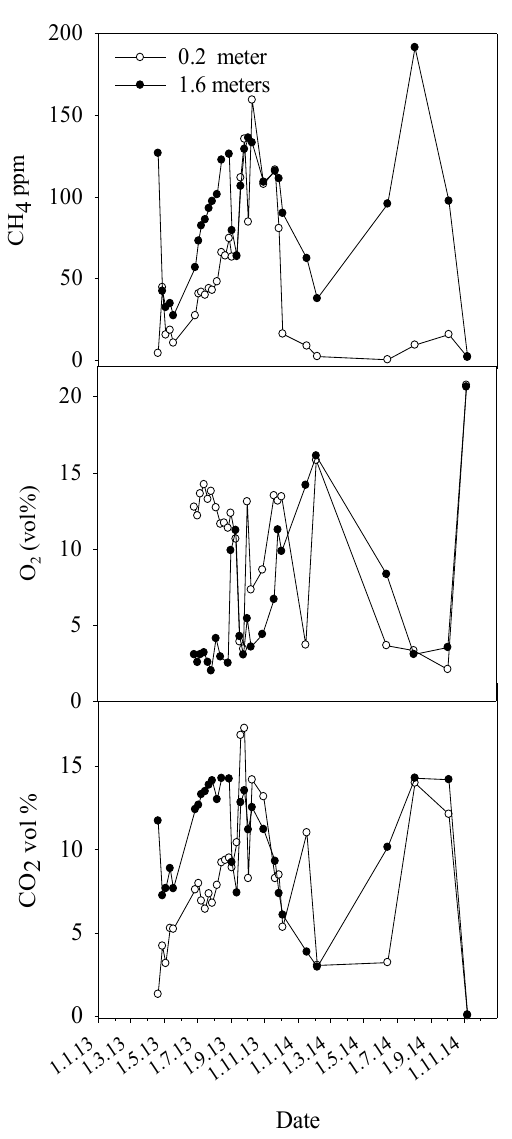
Figure 4. Evolution of in situ concentrations of CH 4, O 2 , and CO 2 at stump level and at breast height within the stem of Norway spruce tree #6 (age 110 years; breast height diameter 44.5 cm; height 29.1 m) at the Ås site. The tree showed combined infection by Heterobasidion annosum s.l. and Armillaria sp. with a four-meter-long decay column in stem heartwood. At stump height with relatively advanced decay in the outermost heartwood, a significant correlation ( p value < 0.01) was observed between CO 2 and O 2 (corr. Coefficient = −0.73) and CH 4 and CO 2 (0.64) stem concentrations. At breast height with incipient decay a significant correlation was observed between CH 4 and O 2 (−0.65), CO 2 and O 2 (−0.98) and CH 4 and CO 2